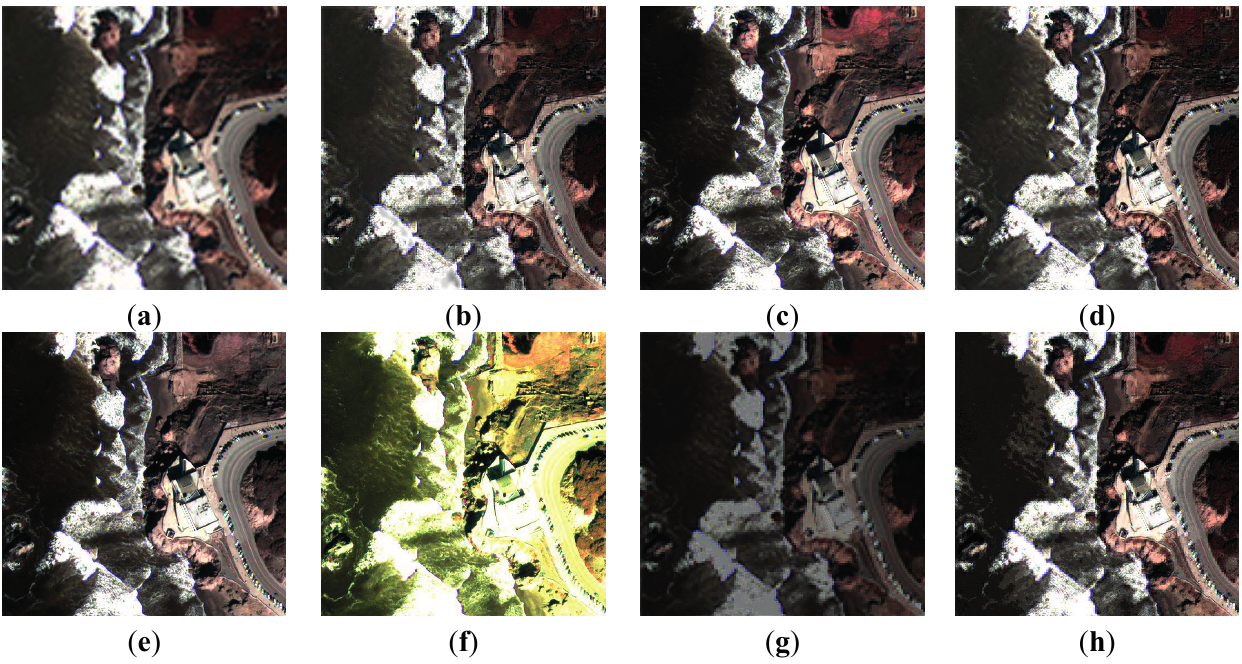
Figure 13. ( a ) Multispectral Image of seaside image. ( b ) BEMD fusion image. ( c ) IHS fusion image. ( d ) Wavelet fusion image. ( e ) PCA fusion image. ( f ) Brovey fusion image. ( g ) Gaussian high-pass spatial filter fused image. ( h ) Laplacian pyramidal decomposition image.